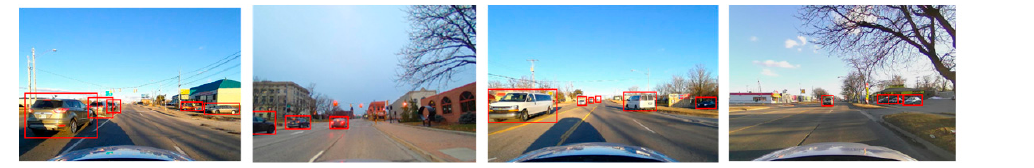
Figure 9. Sample images were collected and labeled to evaluate the DNN models. The red boxes in the images are the ground truth locations of the target objects. Table 1. Evaluation results of the DNN models for vehicle detection.